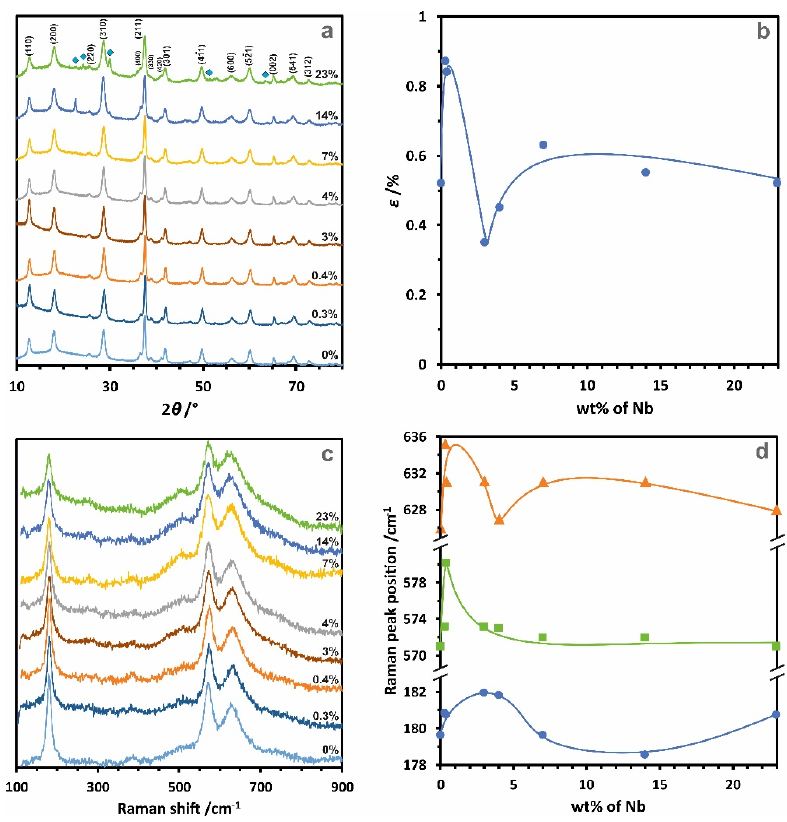
Figure 1. Diffraction patterns ( a ) and Raman spectra ( c ) of Nb/K-OMS-2 with different dopant loadings (0–23 wt%) together with lattice strain ( b ) and the corresponding Raman peaks position ( d ) as a function of the niobium loading.